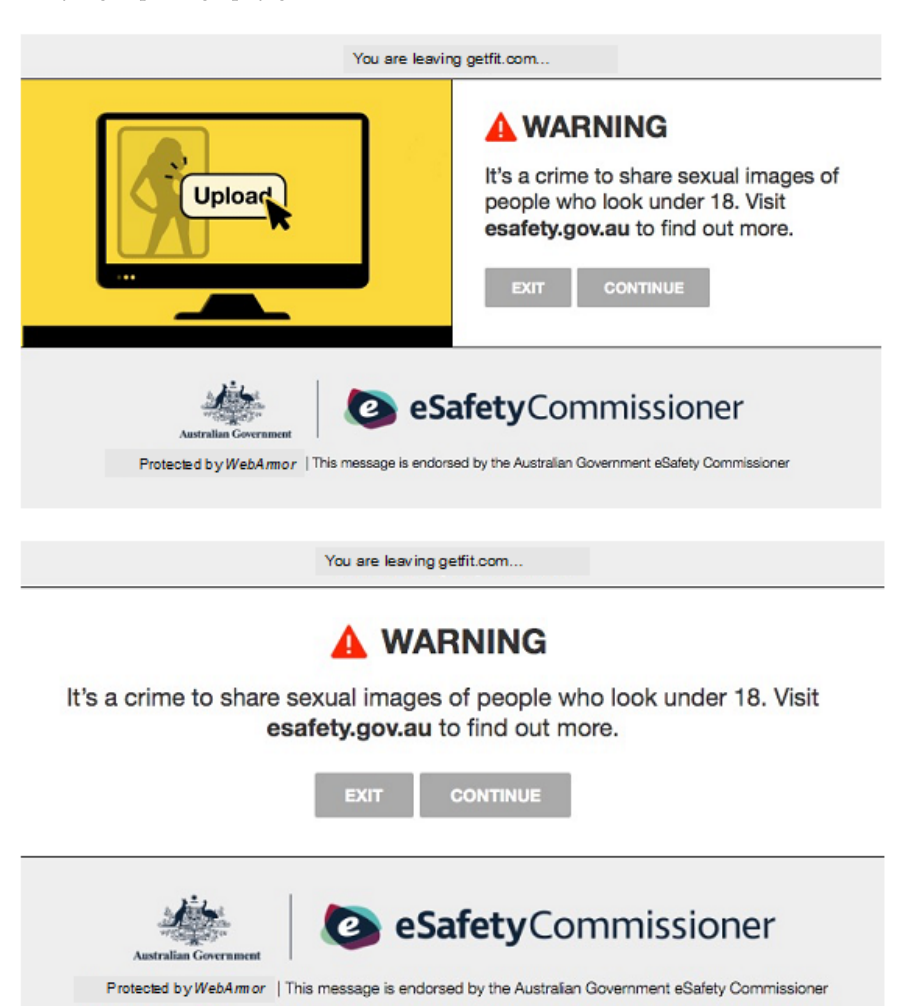
Figure 3. Examples of the messages shown during first experiment with a honeypot styled as the ‘barely legal’ pornography genre.